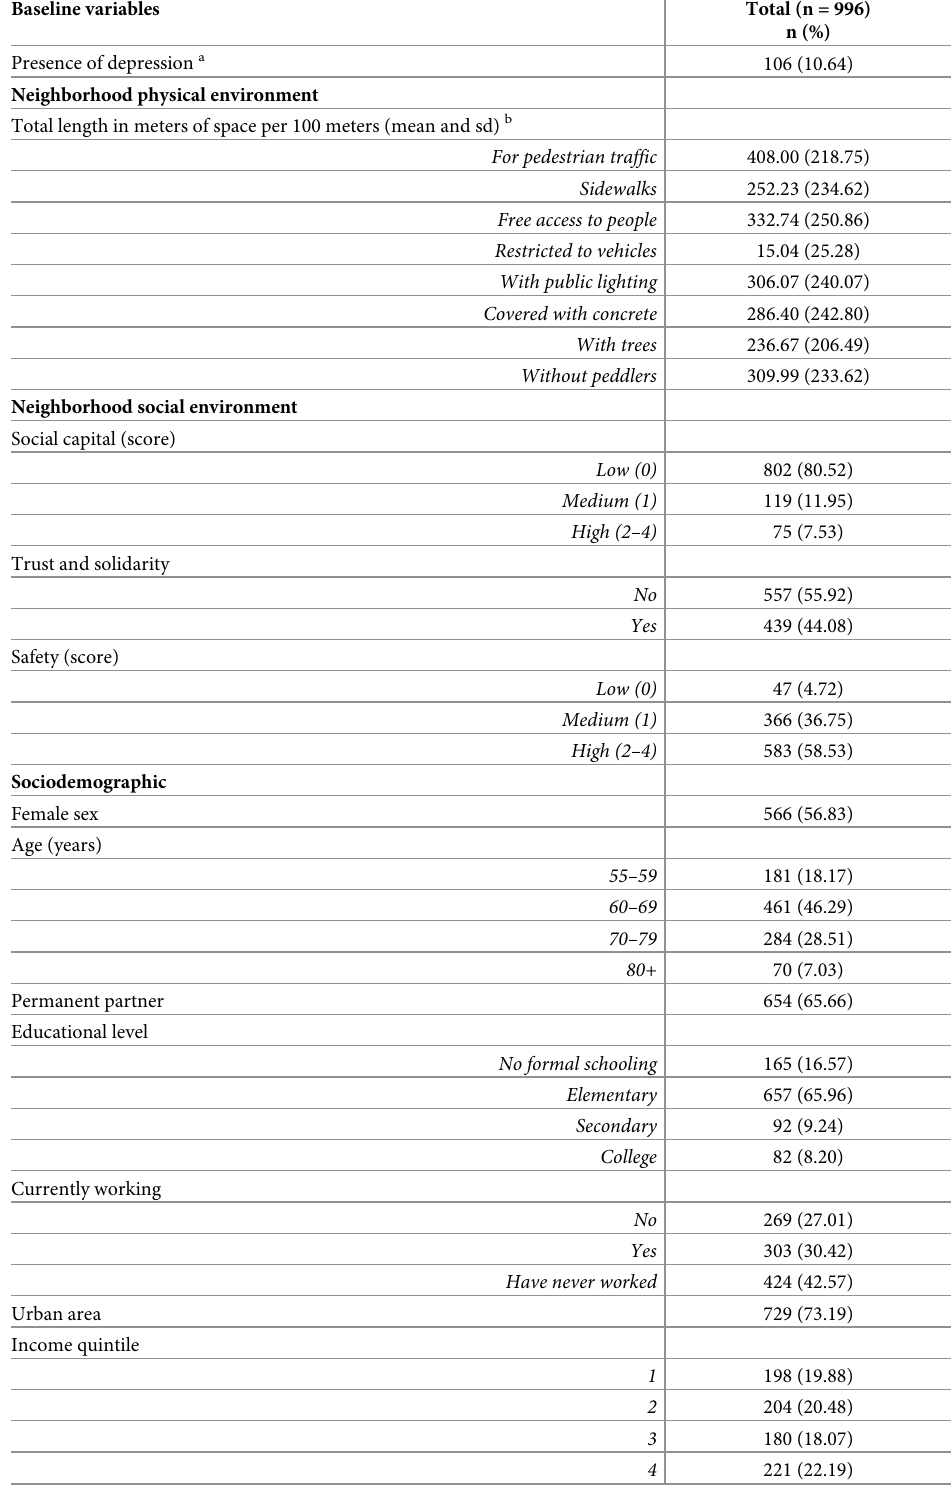
Table 1. Sociodemographic, health-related and neighborhood characteristics of the Mexican older adults from SAGE Waves 1 and 2,